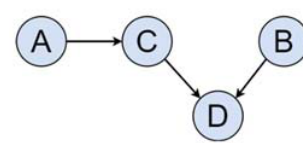
Figure 2. A directed acyclic graph (DAG) representing the factorization (Equation (2)).